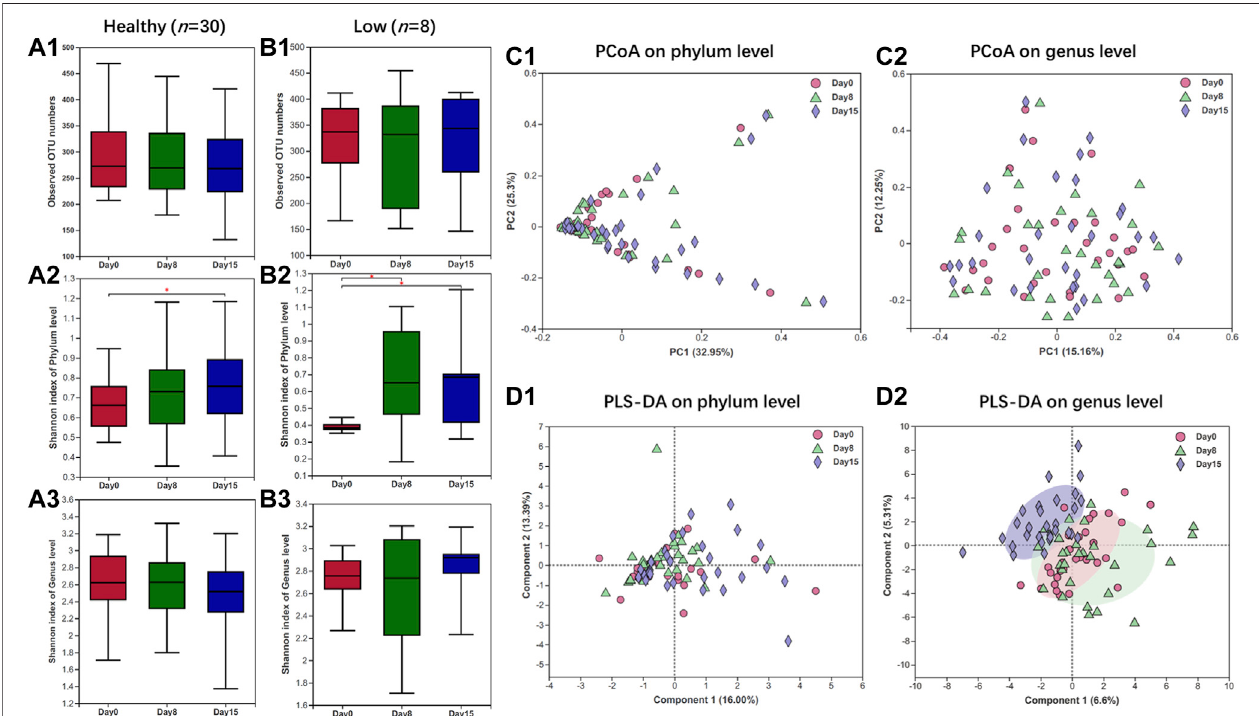
FIGURE 1 | Gut microbial diversity analyses of healthy adults under HXZQ administration for 2 weeks. (A) Alpha-diversity based on observed OTU numbers and Shannondiversityofdonorswithhealthystateofgutmicrobiome( n =30). (B) Alpha-diversitybasedonobservedspecies(richness)andShannondiversityofdonorswith low diversity of gut microbiome ( n = 8). (C) Bray – Curtis principalcoordinate analysis ofgut microbiota of donors with healthy state of gut microbiome ( n = 30). (D) Partial least squares discriminant analysis of gut microbiota of donors with healthy state of gut microbiome ( n = 30). * p -value < 0.05.